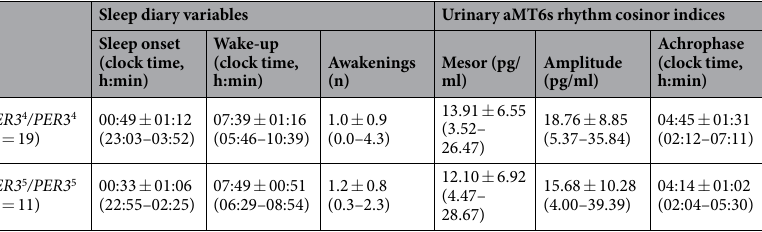
Table 4. Baseline sleep diary and urinary aMT6s rhythm indices, by genotype. Data are expressed as mean ± SD (range). aMT6s: